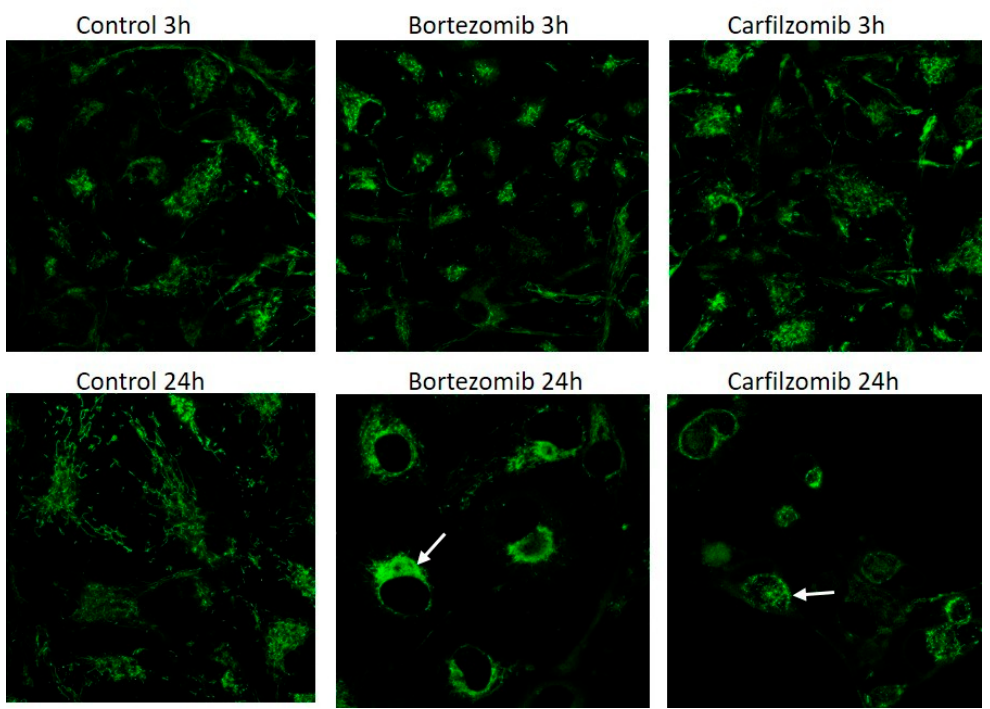
Figure 5. Confocal images of MitoTracker Green FM mitochondrial staining in live neuronal cells after BTZ and CFZ treatments. The white arrows indicate clusters of